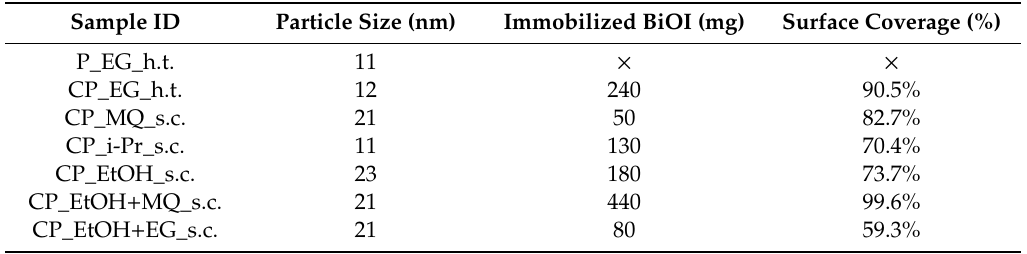
Table 1. The calculated crystal size based on the Scherrer equation, the amount of immobilized BiOI on 8 × 20 cm ceramic paper sheet, and the calculated surface coverage.